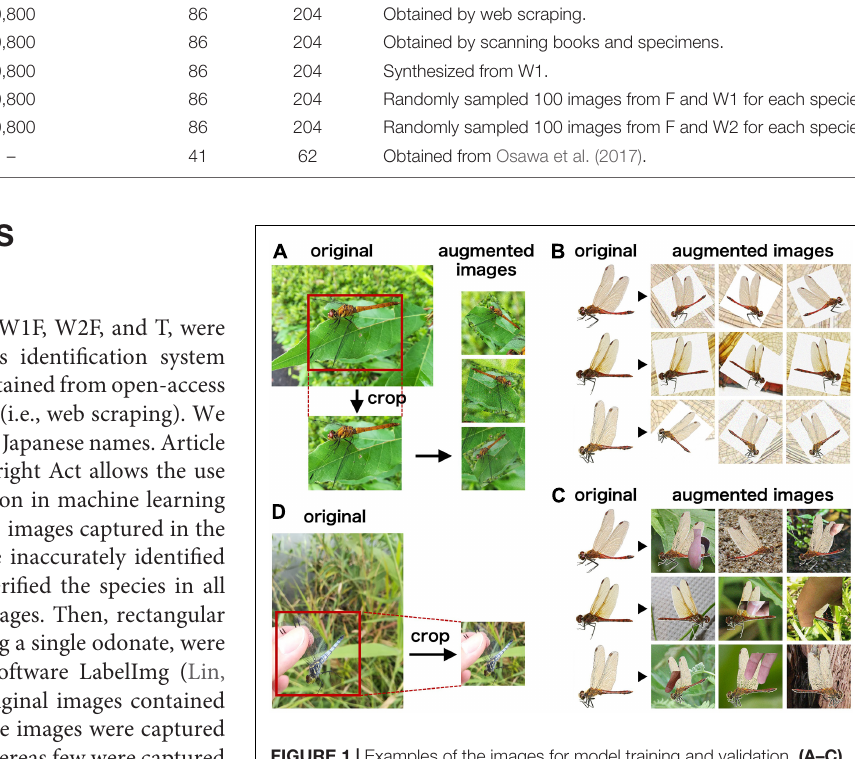
the dataset W1, the dataset W2 included 40,800 images, and all images were resized to a fixed size of 224 × 224